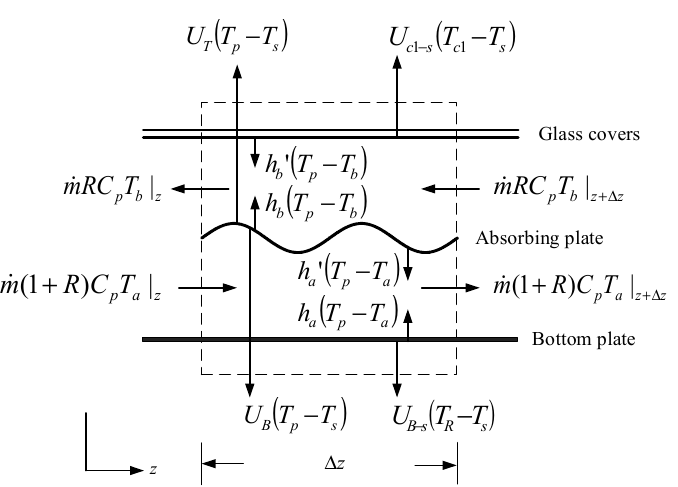
Figure 2. The energy balance made within a finite fluid element.